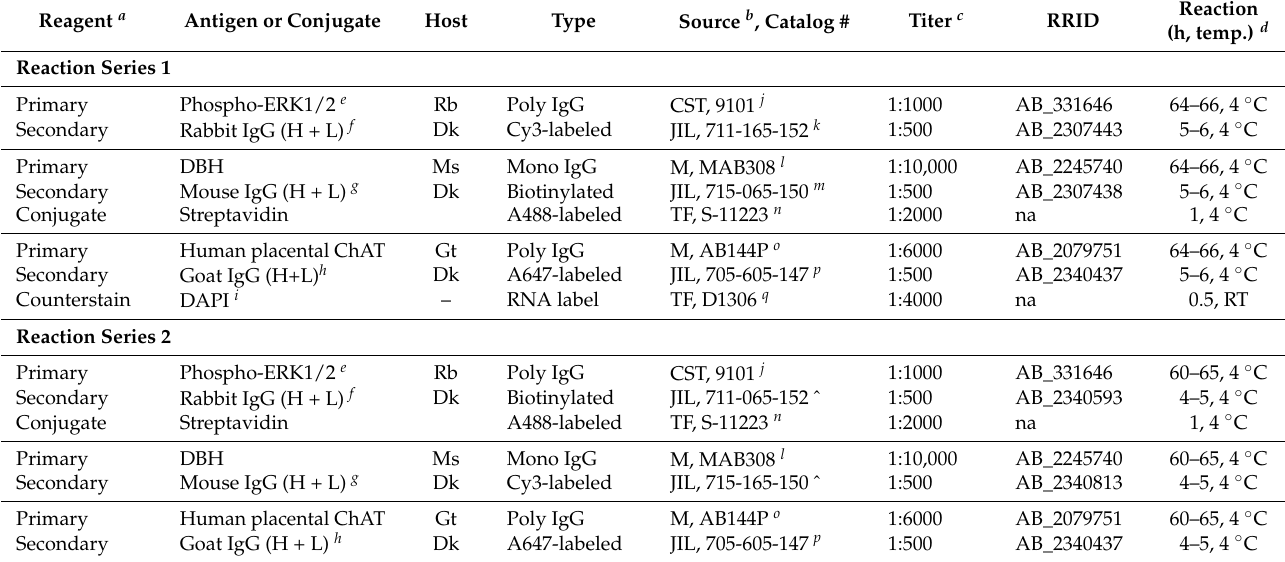
Table 1. Antibody